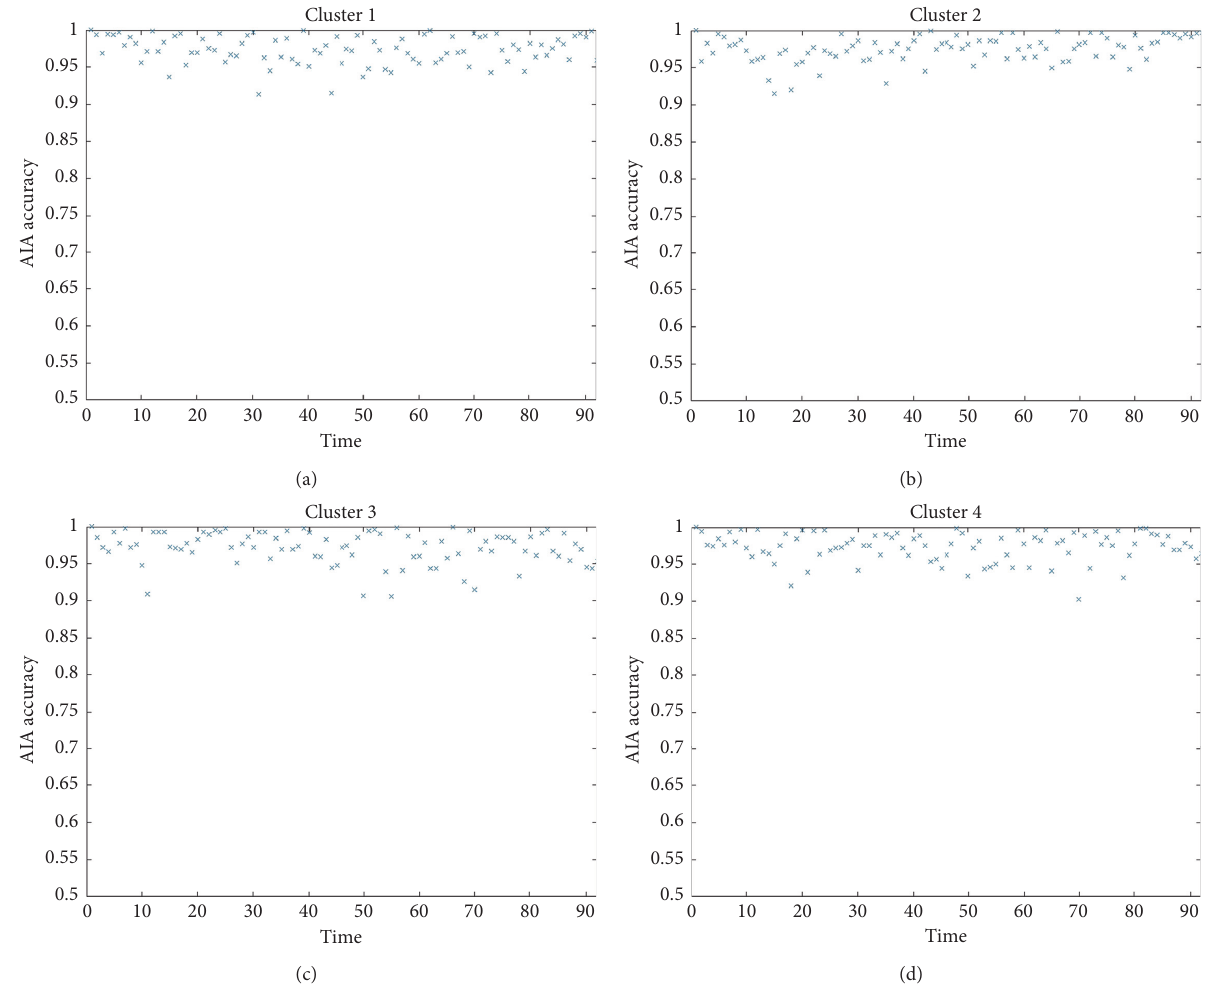
Figure 7: The accuracy of each cluster (city region) from July 1, 2020, to September 30, 2020, based on the accuracy definition of MAIA. The MAIA of each cluster is as follows: (a) Cluster1: 0.973573624; (b) Cluster2: 0.974892885; (c) Cluster3: 0.971613374; (d) Cluster4: 0.973497234. And the MAIA of the entire study area is